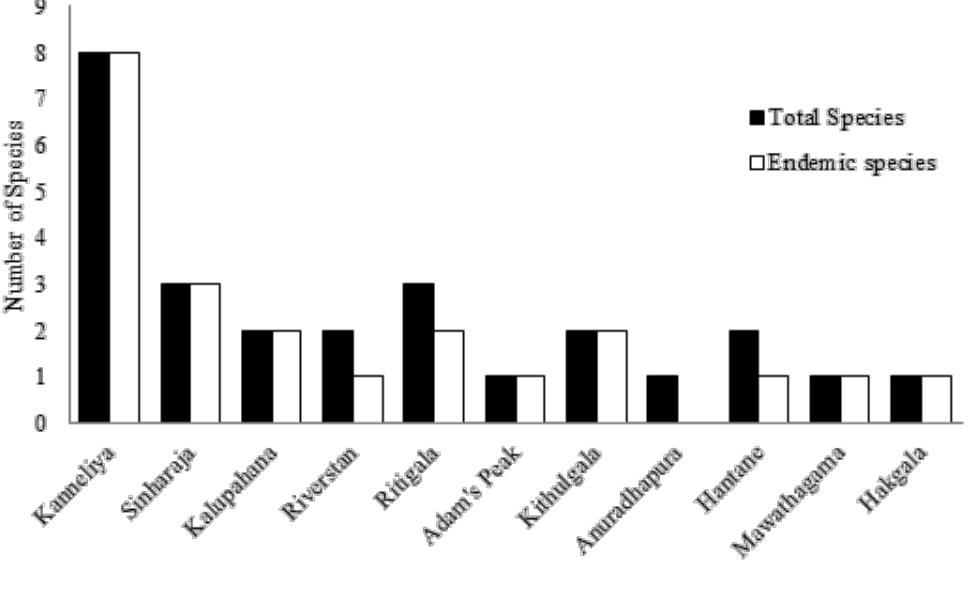
Figure 3: Occurrence of species of the family Anacardiaceae recorded in different sites during the study